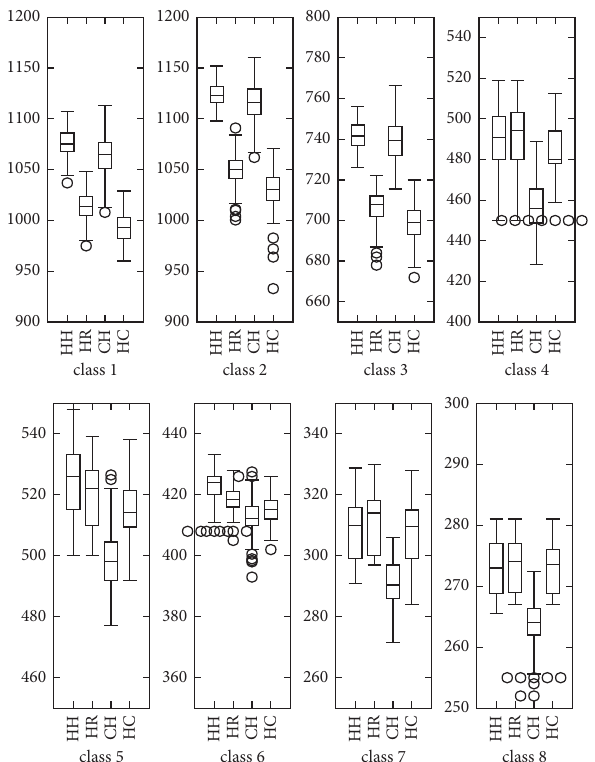
Figure 3: Boxplots of makespans of schedules (minimum, lower quartile, median, upper quartile, maximum, and outliers) returned by the LS algorithms for the SCP1 classes nos. 1, 2, 3, and 4 (top fgures) and classes nos. 5, 6, 7, and 8 (bottom fgures) with cov � 80%.